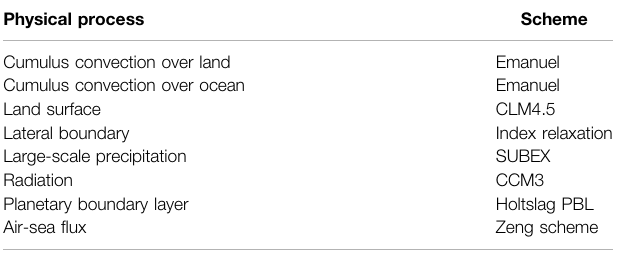
TABLE 1 | List of physical parameterization schemes used in the simulation. Physical process